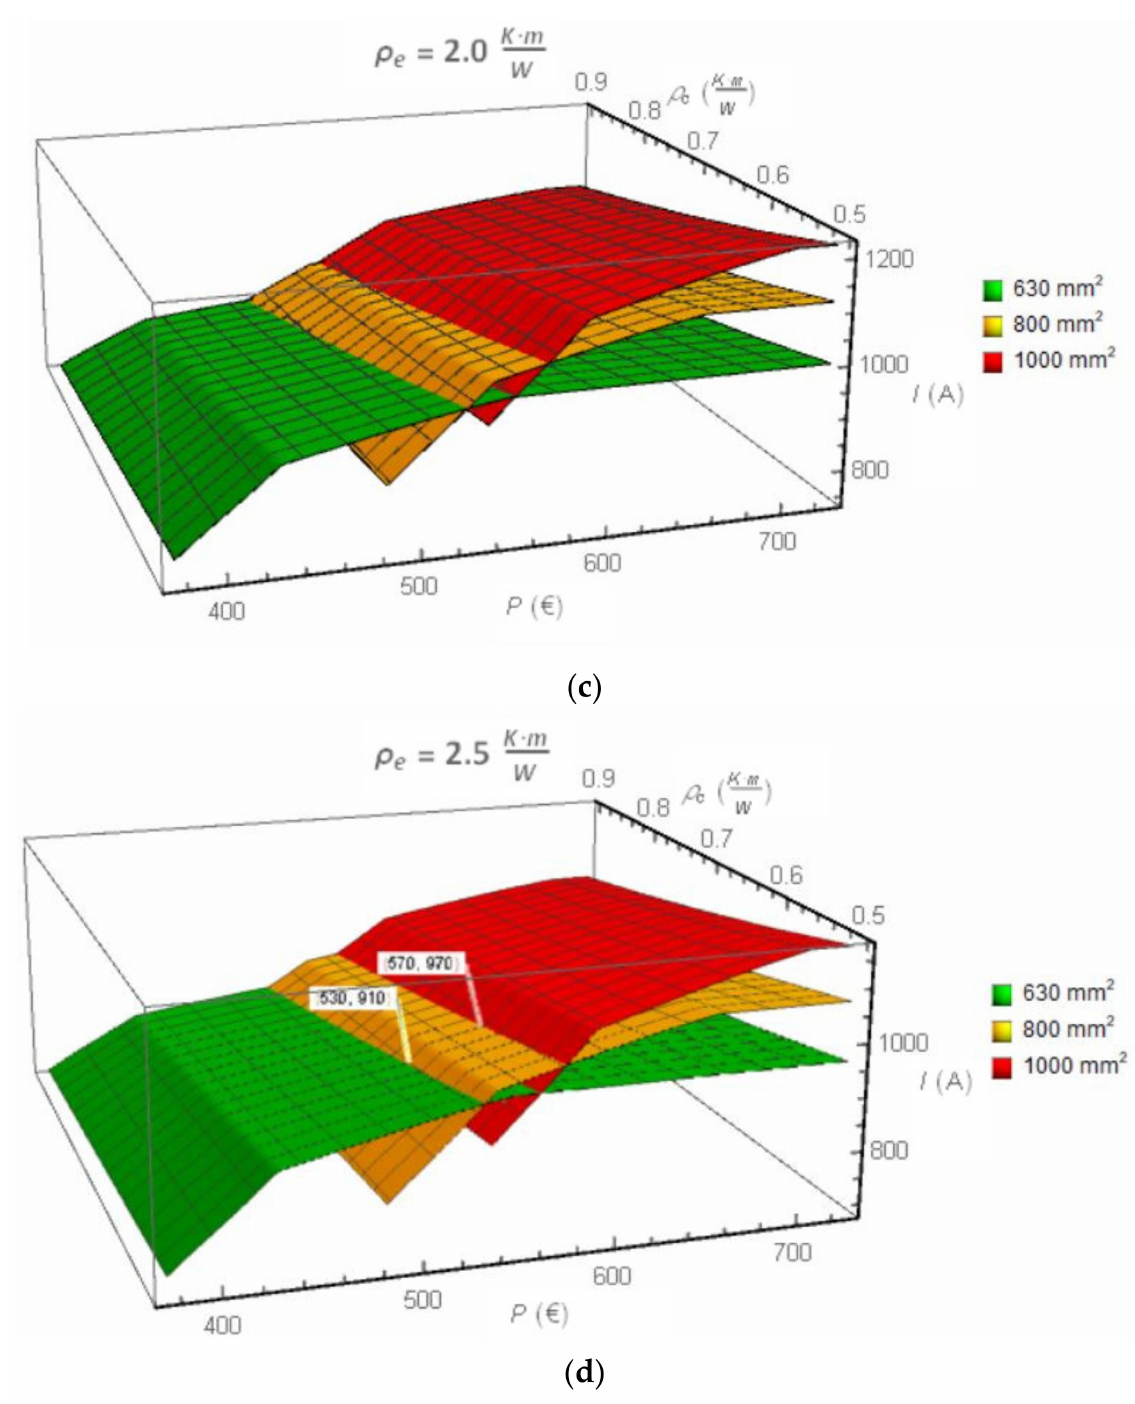
Figure 4. Ampacity I of the cable line with cables (630 mm 2 , 800 mm 2 and 1000 mm 2 ) laid in the trefoil formation, as a function of costs P and thermal resistivity of the backfill ρ c ; thermal resistivity of the native soil: ( a ) ρ e = 1.0 (K · m)/W; ( b ) ρ e = 1.5 (K · m)/W; ( c ) ρ e = 2.0 (K · m)/W; ( d ) ρ e = 2.5 (K · m)/W. Characteristic example points in ( d ): (EUR 530, 910 A) and (EUR 570, 970 A)—the cost efficient transition to the cable of higher cross-section (for ρ c = 0.6 (K ·